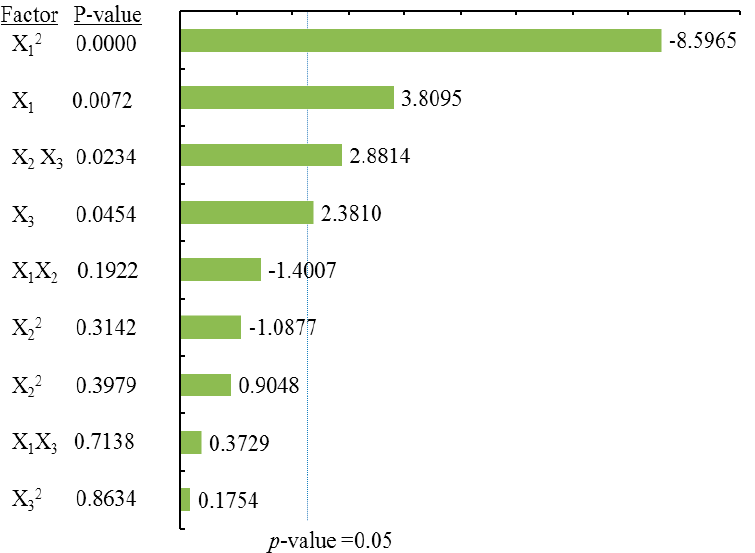
Figure 6. Pareto chart of the effects for the myricetin yield. Standardized effect estimate (absolute value). (absolute